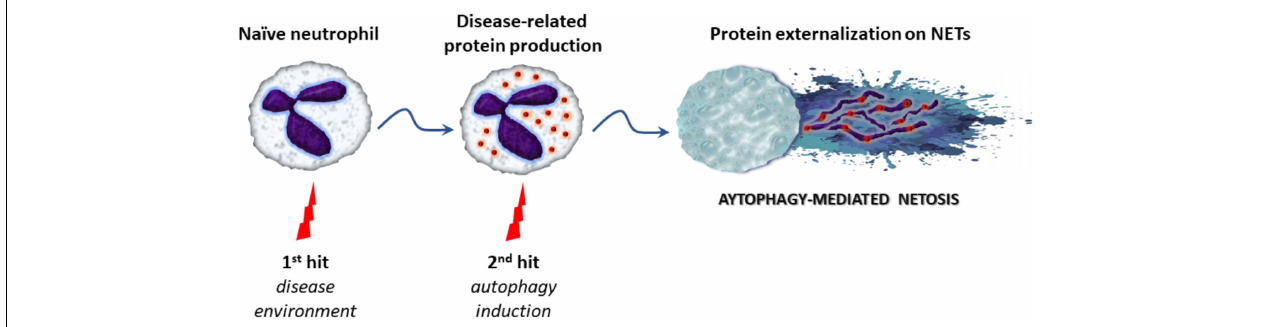
FIGURE 2 | The proposed “two-hit” model in autophagy-mediated NETosis. Initially, various stimuli derived from the inflammatory microenvironment stimulate the production of disease-related proteins in naïve neutrophils (first-hit). Subsequently, triggering of autophagy (second-hit) leads to NET formation and the extracellular release of proteins via NET scaffold, contributing to antimicrobial capacity or inflammatory potential of the